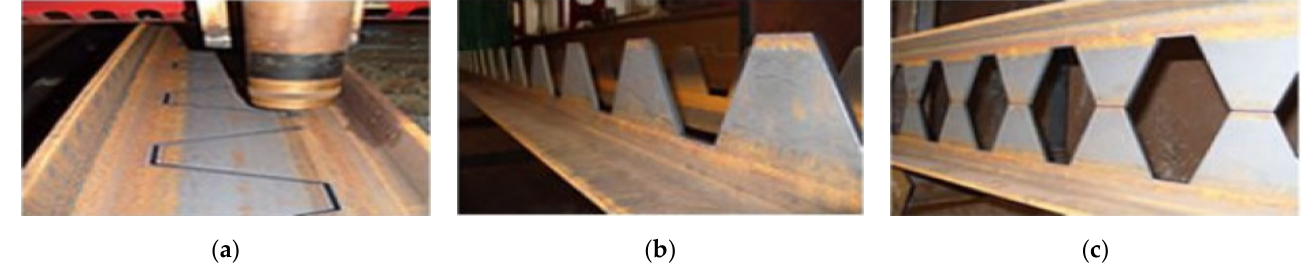
Figure 1. Castellated beams manufacturing process [5]: ( a ) Cutting; ( b ) Parting; ( c ) Welding.